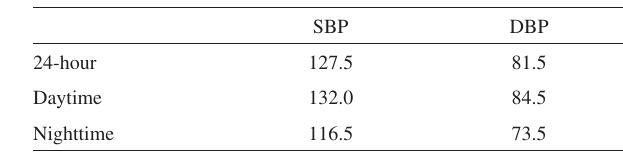
Table 4 – Median blood pressure